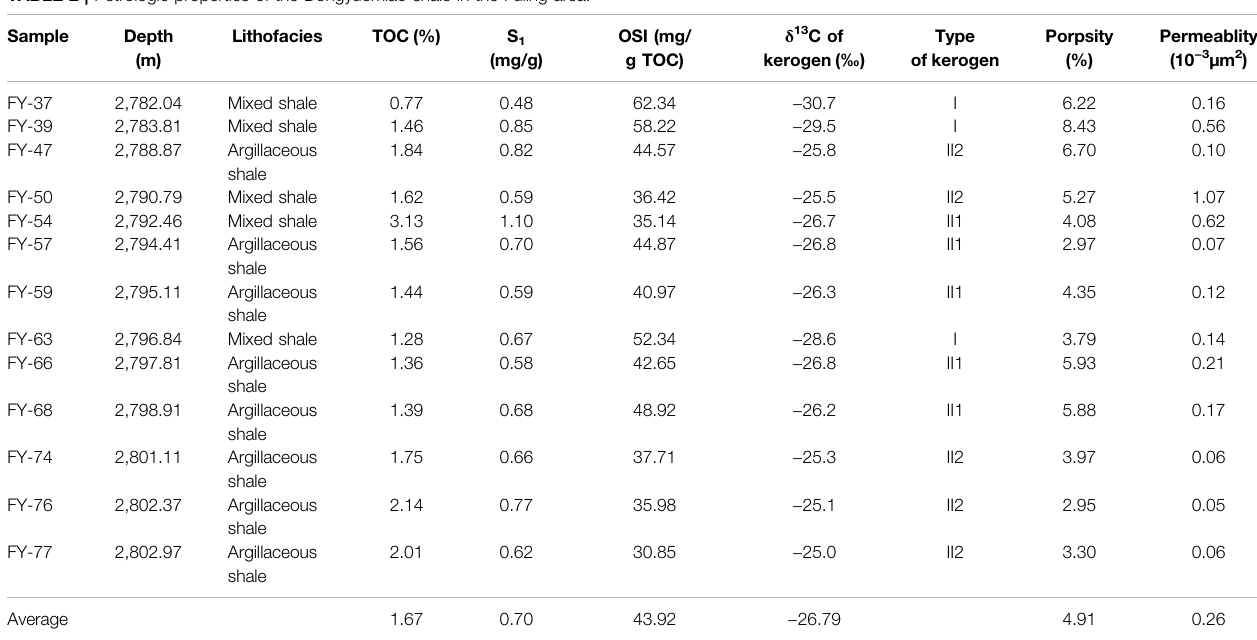
TABLE 2 | Petrologic properties of the Dongyuemiao shale in the Fuling